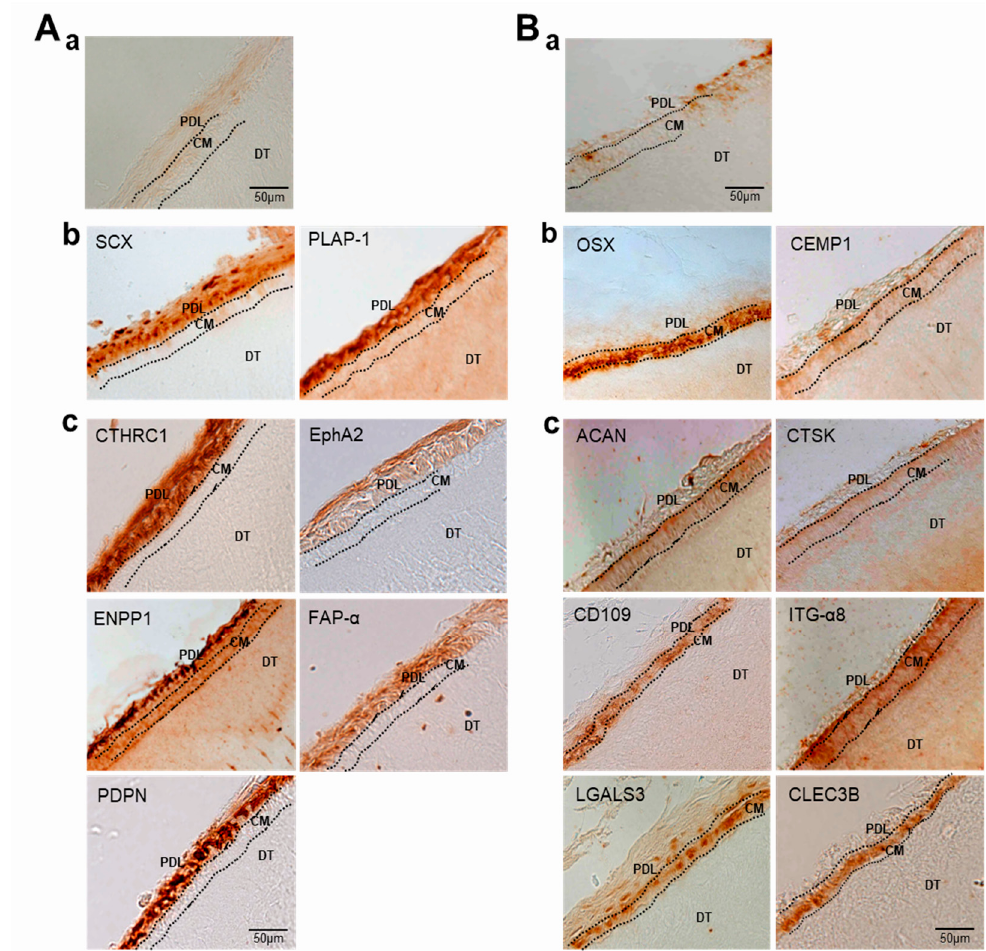
Figure 8. Validation of the expression of DEGs by immunohistochemistry. Immunohistochemical staining of PDL ( A ) and cementum ( B ) in tooth roots. ( a ), negative control by staining with the secondary antibody only; ( b ), staining with the antibodies of the already known markers; ( c ), staining with the antibodies of the selected upregulated DEGs. PDL, periodontal ligament; CM, cementum; DT, dentin.